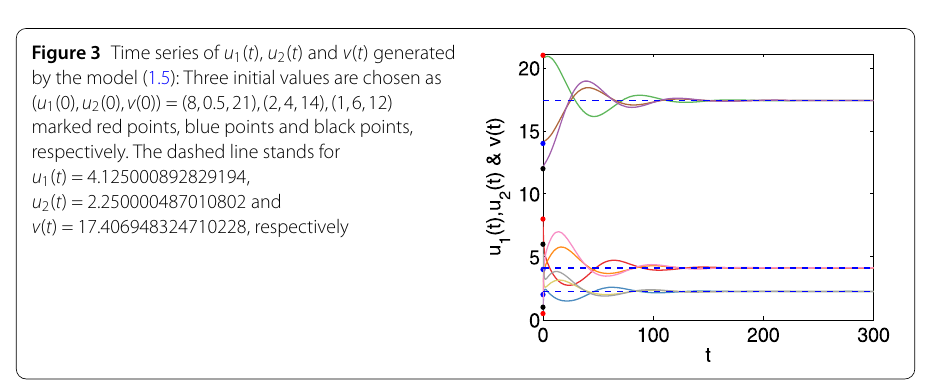
Taking a = 1.1; b = 1